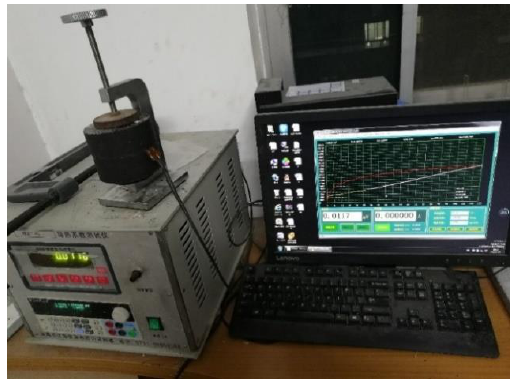
Figure 7. Experimental setup.